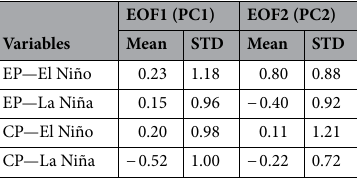
Table 1. Mean, standard deviation of normalized PC1 and PC2 in different ENSO